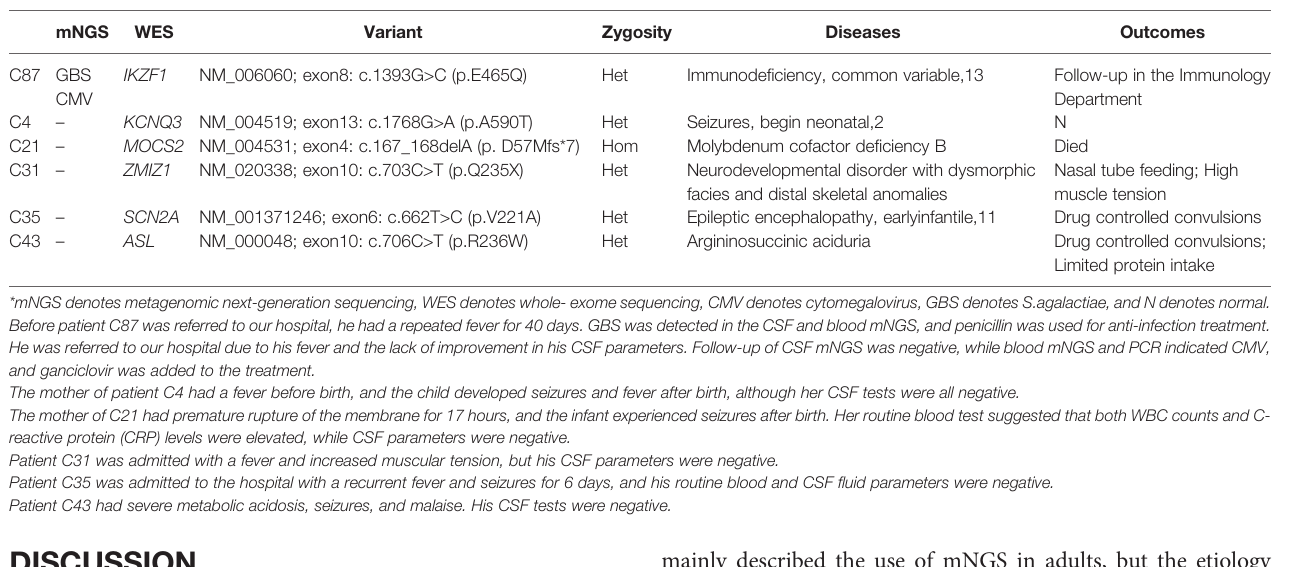
TABLE 2 | Six patients with de fi nited genetic